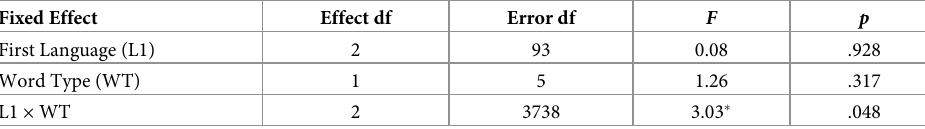
Table 3. Fixed effects results from LMMs considering English Target Language